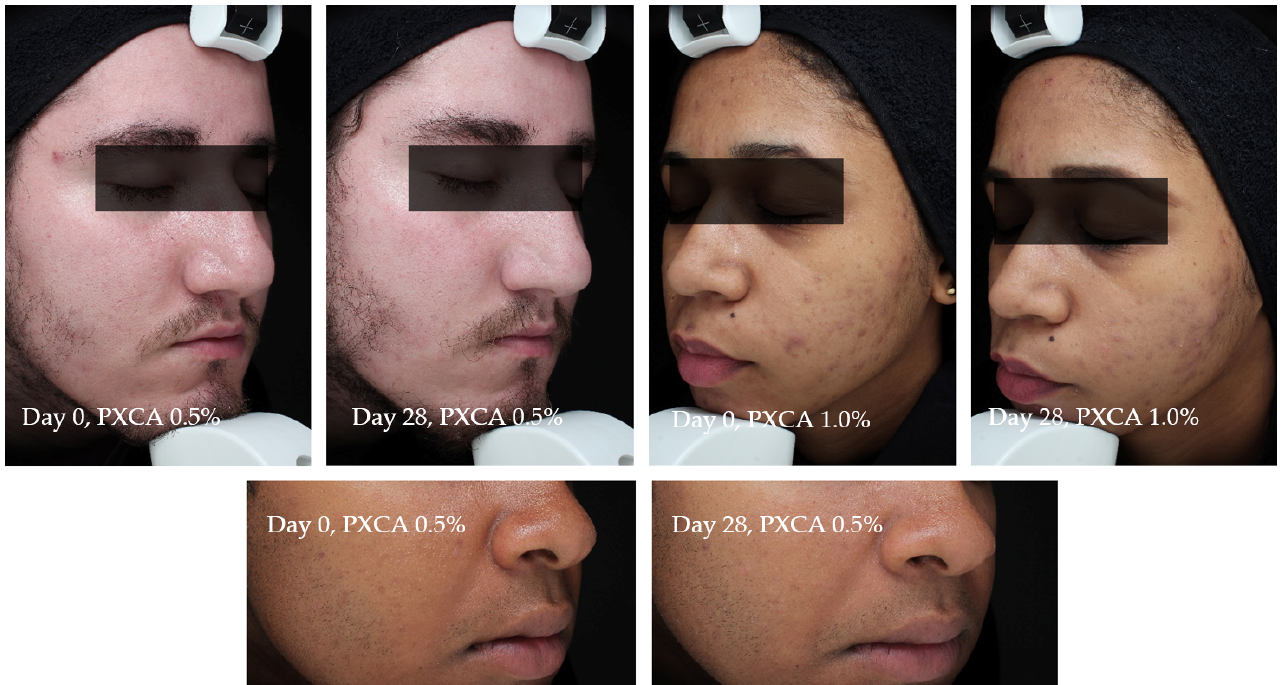
Figure 7. Photographs from three participants illustrating the improvement in the skin aspect/appearance after 28 days of treatment with PXCA 0.5% or 1.0%.